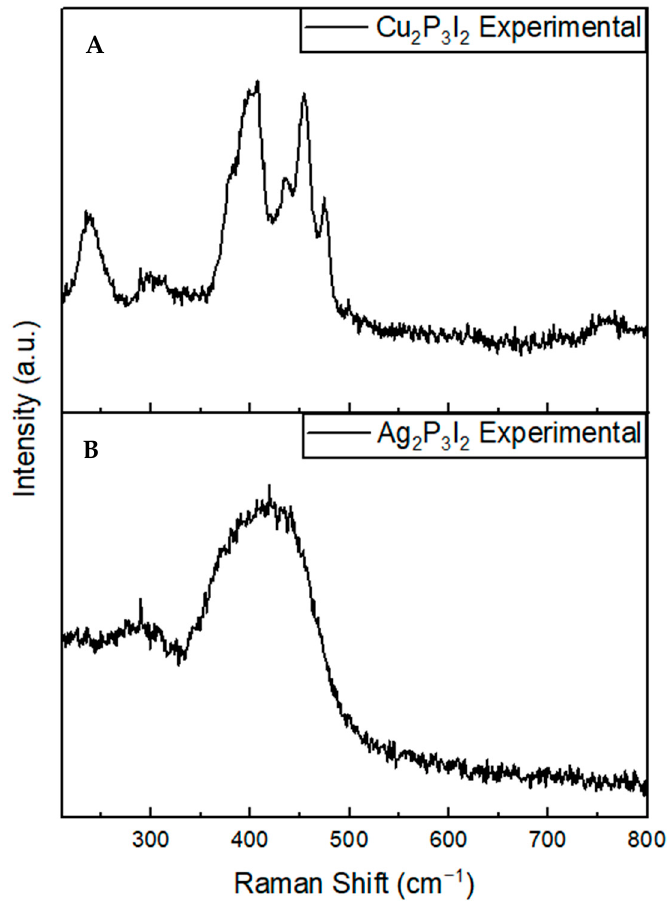
Figure 2. The Raman spectrum of a sample of Cu 2 P 3 I 2 produced by chemical vapor transport ( A ) and Ag 2 P 3 I 2 produced by post-synthetic modification ( B ).